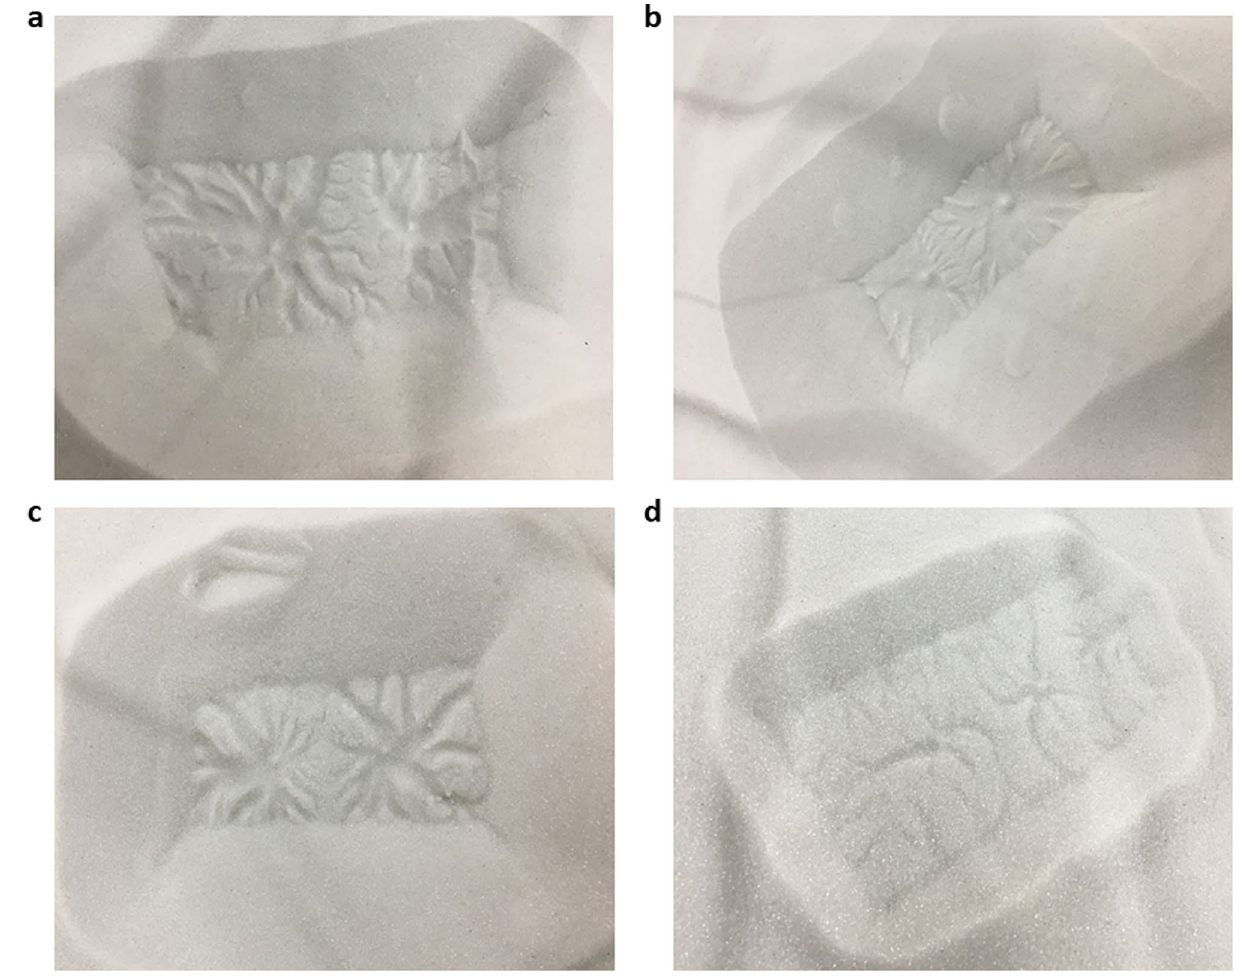
Figure 5. Double araneiforms. Double araneiforms formed on beds of grain sizes ranging from 150 to 600 µ m when two 3 mm vents were created at the centre of the incident block, 6 cm apart. ( a ) Shows double araneiforms on 150–250 µ m grains. ( b ) Shows double araneiforms on 150–250 µ m grains. ( c ) Shows double araneiforms on 250–425 µ m grains. ( d ) Shows double araneiforms on 450–600 µ m grains. Sublimation was highly vigorous for the 160–212 µ m experiments, particularly with two central vents. This caused rapid sediment transport back on top of the block and pit and hence surface features were concealed by this burying (Fig. 7), similar to the Martian forms. In the majority of cases the troughs were radially organised, barring the instances where they appeared to interlink and overlap in a more disorganised ‘lace’ morphology. All radial dendritic patterns formed in one instance and did not require multiple events of trough connection towards a common centre. As the block was uniform in each case, the gas flowed beneath the block to the central vent. Plume observations. Plumes of CO 2 ejecta entraining sediment were observed in each case (Video 1). These are the first observations of plumes depositing material on top of ice and consequently eroding radial aranei- form structures. These types of plumes; driven by momentum but denser than the ambient fluid are known in the fluid dynamic community as fountains. Unlike on Mars where winds are thought to frequently redistribute the jetted subsurface material in fan shapes away from the centre of the araneiform, the material carried within the plume either fell down onto the surrounding bed or directly back down through the vent. The latter process formed a central raised spot within the central depression. Plume height was simply observed and not measured because in some cases, the plume height was limited by the height of the chamber but differences according to (1) vent diameter and (2) grain size, could be quantitatively observed. Vent diameter affected plume height sig- nificantly, with ejecta from plumes emanating from 3 mm diameter vents reaching the chamber ceiling ( ∼ 0.6 m above the bed surface) in many cases at high velocity relative to plumes from 5 mm vents, while 5 mm vent plumes were more diffuse, with grains only reaching the top of the claw ( ∼ 0.15 m above the bed surface). This is to be expected since as we showed earlier the velocity in the vent will be U = Aq / a , so if the vent radius decreases from 5 to 3 mm the velocities will increase by ( 5 / 3 ) 2 and the height of the resulting granular plume by